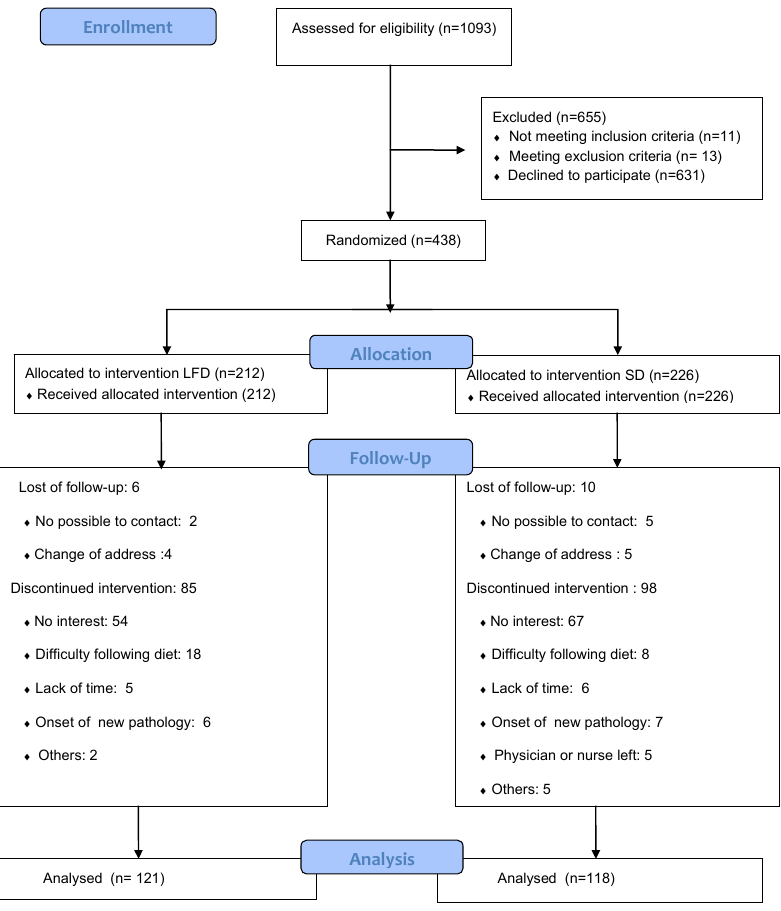
Figure 1. Flow diagram.